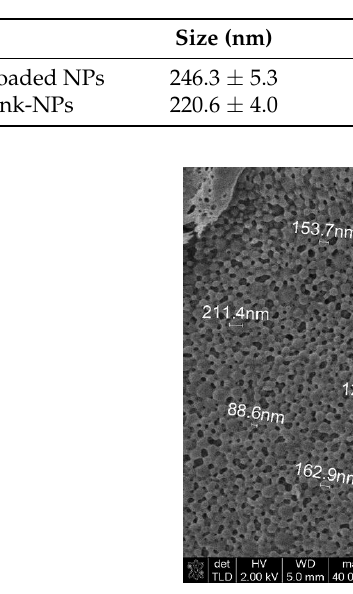
Table 3. Characterization of indicative batches of blank PLA nanoparticles (blank-NPs) and PLA nanoparticles loaded with oil leaves extract (OLE-loaded NPs): particle size, polydispersity index (Pdi), ζ -potential, encapsulation efficiency (EE).